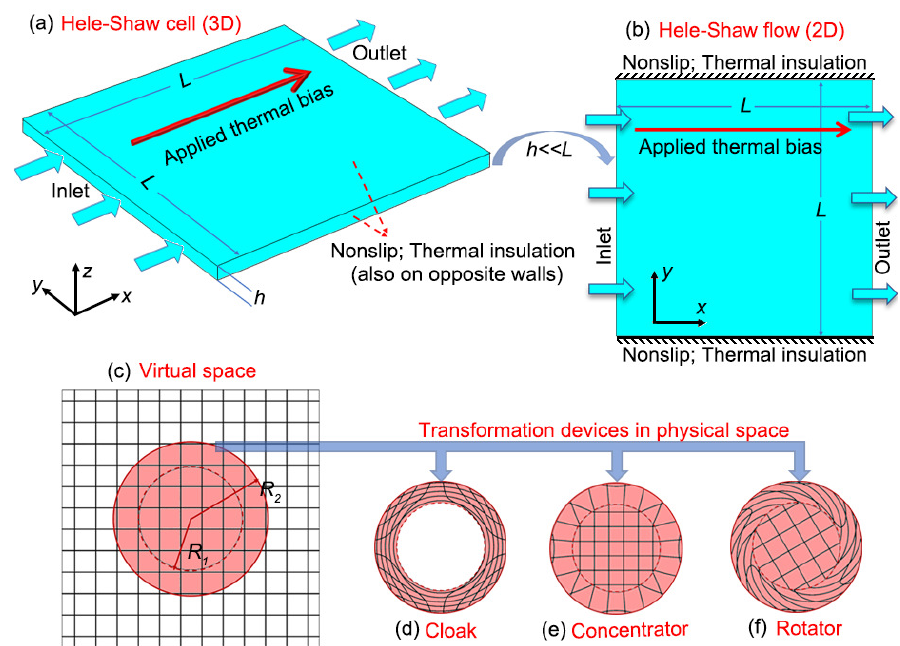
Figure 1. ( a ) Geometry of a Hele–Shaw cell (indicated by transparent color). The dark-colored areas inside represent fluid domain with a depth denoted by h . The length and width of the fluid in the horizontal plane are both L . The two sides parallel to the y - z plane are the inlet and outlet of the fluid. The other four sides are solid walls that are insulated and non-slip. A thermal bias is applied along the x -axis; ( b ) schematic of a 2D Hele–Shaw flow. It has the same size as the top view of the Hele–Shaw cell. The inlet and outlet are along the direction of the y -axis. The boundaries along the direction of the x -axis are insulated and non-slip; ( c ) the 2D virtual space for designing transformation media. The red disk undergoes non-trivial transformations to become functional devices. The region outside it undergoes an identity transformation; ( d , e , f ) are the physical space for the cloak, concentrator and rotator, respectively. The distorted meshes correspond to their respective transformations and